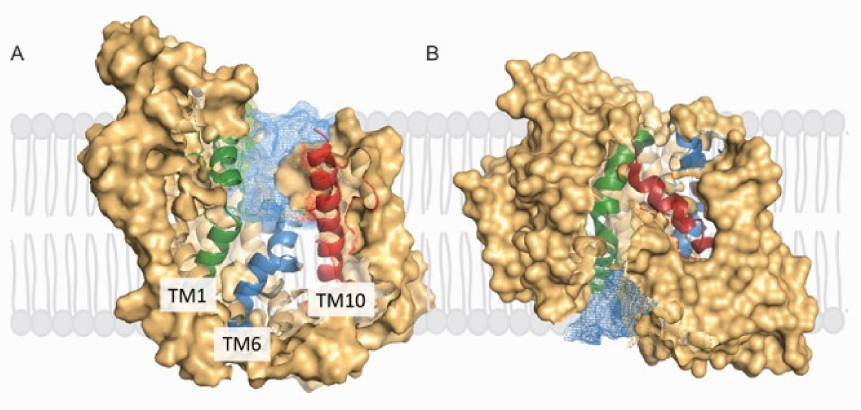
Figure 6. Alternating access of vSGLT . ( A ) Slice through surface of the outward-facing model viewed from the membrane plane showing the extracellular cavity (blue mesh) [8,29]. ( B ) Slice through surface of the inward-facing structure of vSGLT (PDB: 3DH4) in the membrane plane showing the intracellular cavity (blue mesh). Helices showing large structural rearrangement are colored green (TM1), blue (TM6) and red (TM10) with the surface is shown in